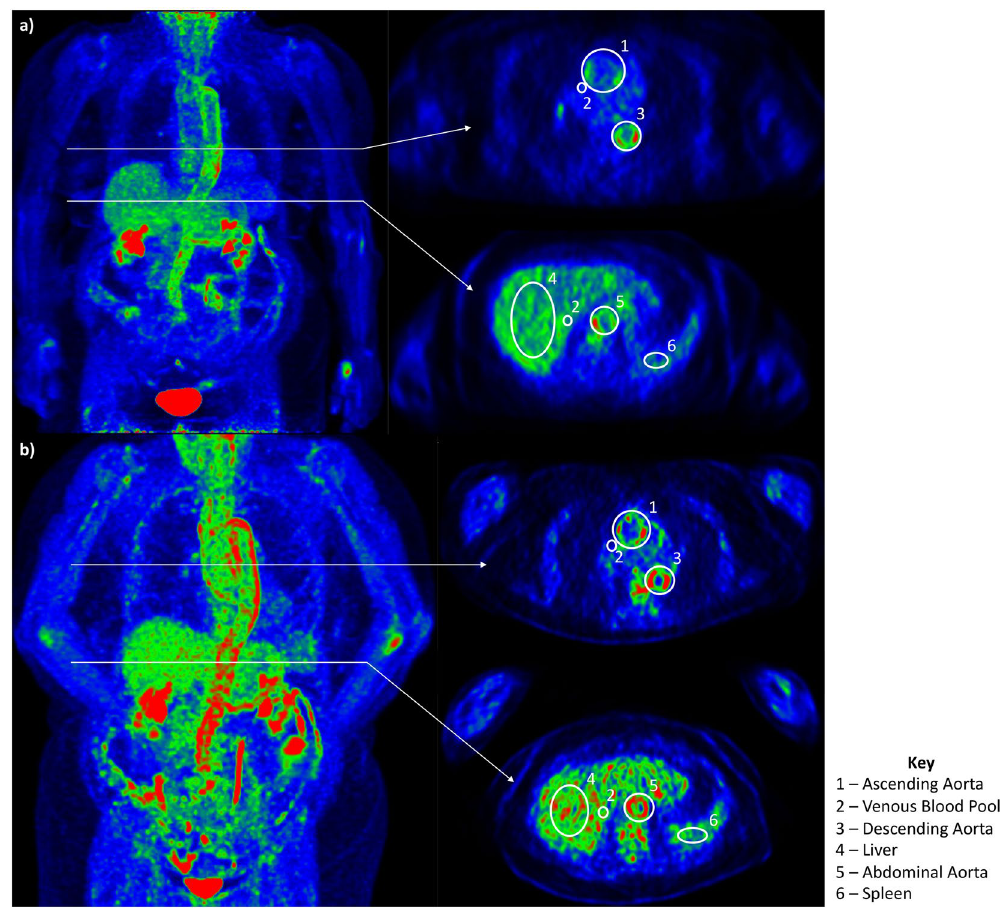
Figure 1. Examples of contoured regions of interest at the one-hour and two-hour imaging time point from FDG-PET studies performed in the same patient. ( a ) One-hour PET 3D reconstructed maximum intensity projection (left) with representative contouring of the ascending 1 and descending 3 aorta and venous blood pool 2 (top), and contouring of the liver 4 , venous blood pool 2 , abdominal aorta 5 , and spleen 6 (bottom). ( b ) Two-hour PET 3D reconstructed maximum intensity projection (left) with representative contouring of the ascending 1 and descending 3 aorta and venous blood pool 2 (top), and contouring of the liver 4 , venous blood pool 2 , abdominal aorta 5 , and spleen 6 (bottom). Images windowed to Max 4.0, Min